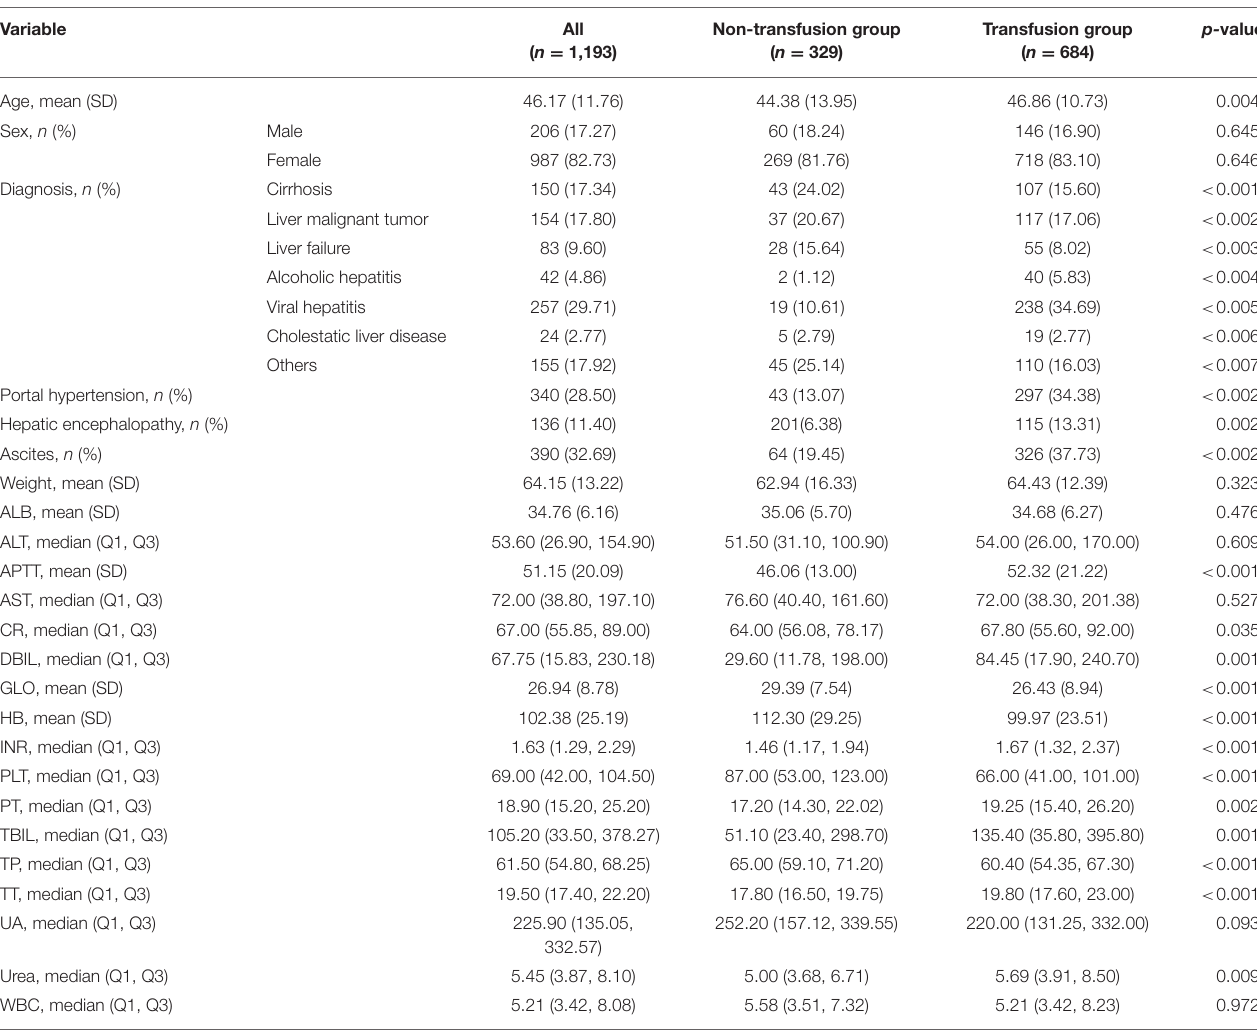
TABLE 1 | Preoperative